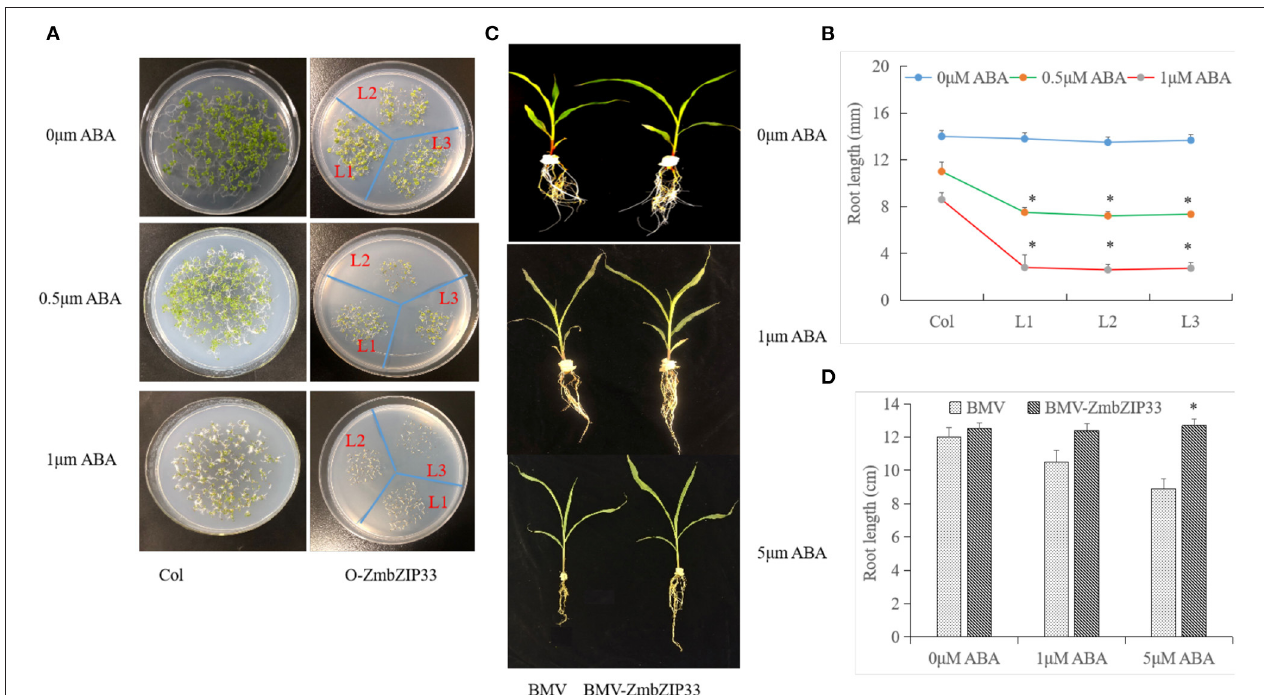
FIGURE 7 | Analyze ABA sensitivity of overexpressing and silencing ZmbZIP33. (A) Seeds of wild-type (Col) and transgenic plants (L1–L3) germinated and were grown on MS medium with 0, 0.5, and 1 µ mol/L ABA for 10 days. (B) Statistical analysis of the root length of transgenic Arabidopsis plants and Col grown on MS medium. (C) Three-leaf-stage of BMV and BMV-ZmbZIP33 mutant were grown in Hoagland’s nutrient solution containing 0, 1 and 5 µ mol/L ABA for 5 days. (D) Statistical analysis of the root length of BMV-ZmbZIP33 and BMV. Mean values and standard errors (bar) were shown from five independent experiments.